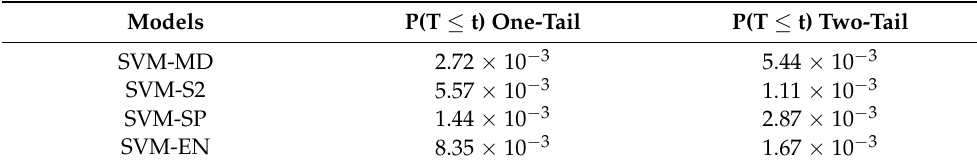
Table 8. t -test: basic SVM and enhanced SVMs sample for variance for RC